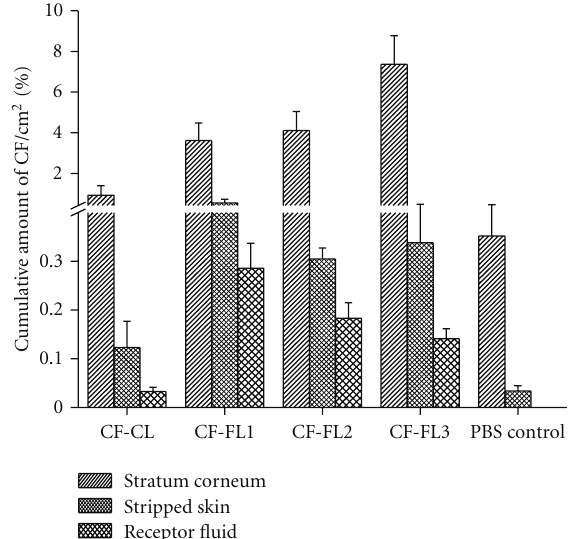
Figure 4: Amount of CF delivered into the SC, Stripped skin and the receptor fluid after 6 h of incubation with rat skin (CF- CL: conventional liposomes; CF-FL1: flexible liposomes containing sodium cholate; CF-FL2: flexible liposomes containing tween 80; CF-FL3: flexible liposomes containing cineole and ethanol. The controls present the PBS